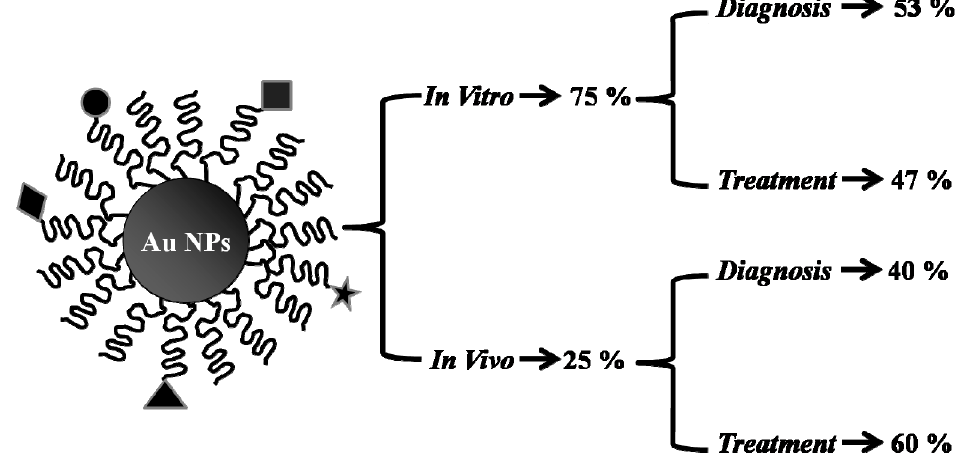
Figure 4. Distribution profile of the studies done using AuNPs on PCa. The majority of the studies done on PCa using AuNPs involved in vitro applications (~75%). Almost half of the studies were dedicated to diagnostic or to treatment purposes, and the majority of the in vivo studies (~60%) involved therapeutic applications. The curved line outside the AuNP represents the stabilizing agent layer that is used to form and stabilize the nanoparticles, and allow for the conjugation of different types of ligands, some of which, for example, could be bifunctional polyethyleneglycol (PEG), polysaccharides, polyethylenimine, or a crosslinker. The circle, lozenge, square, star, and triangle refer to the various types of conjugating ligands (Epigallocatechin gallate, siRNA, antibodies, and folic and anisic acid).